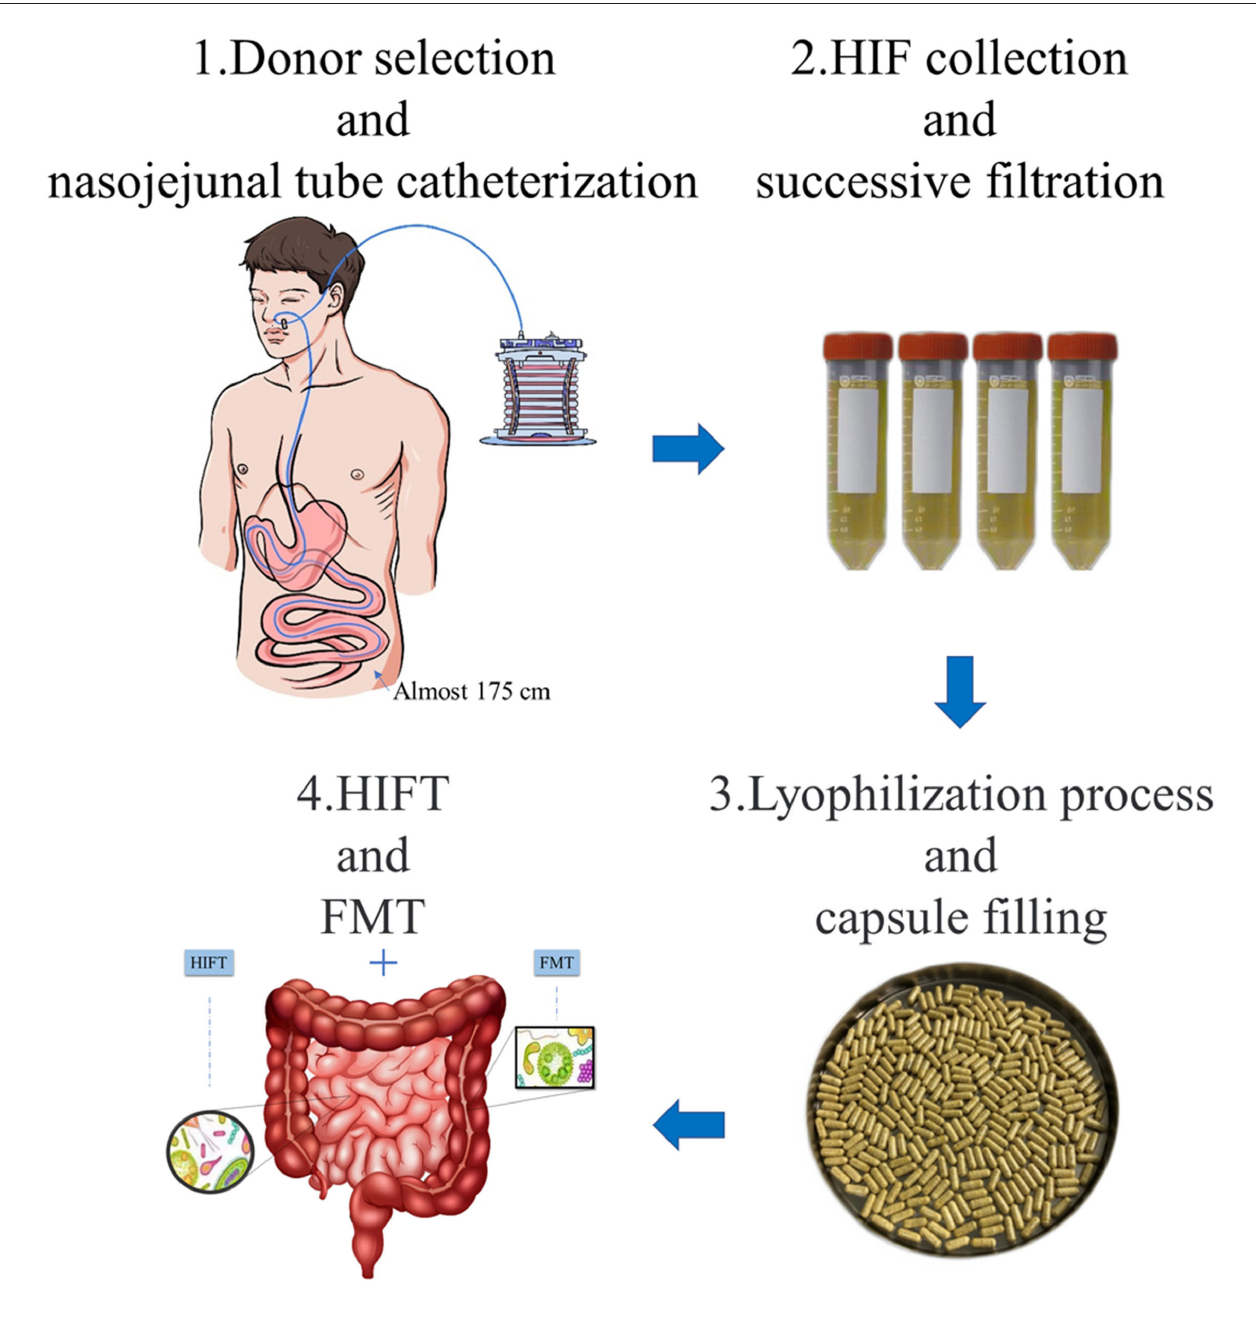
FIGURE 1 | Preparation and application of HIFT capsules. 1. Donor selection and nasojejunal tube catheterization: eligible donors underwent nasojejunal tube catheterization by using a modified Flocare nasogastric feeding tube. Modified disposable sterile negative pressure collecting devices were connected to the catheter for continuous drainage. 2. HIF collection and successive filtration: the HIF was collected in the devices and transferred to filtration in 2h. The filtration used screen cloths of 2.0mm, 1.0mm, and 0.5mm. 3. Lyophilization process and capsule filling: 10% glycerin was added to the filtrate as a cryoprotectant and HIF was turned into the lyophilized powder by lyophilizer. The lyophilized powder was packaged in an enteric capsule shell of an acid-resistant acrylic resin, which would only disintegrate in small intestine. 4. HIFT and FMT: HIFT can be used in combination with FMT, in diseases that respond poorly to FMT treatment. In other words, it is a treatment of whole intestinal microbiota